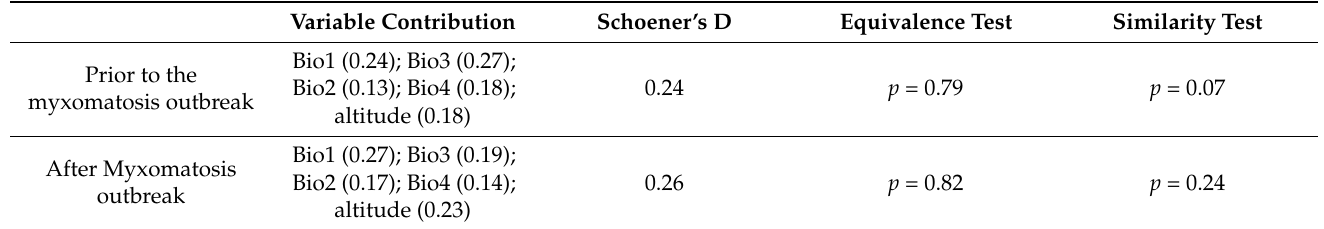
Table 5. Schoener’s D and p -values of equivalence and similarity test under conservatism hypothesis. Contribution of variables also provided. Bio1–Bio4: four levels of CORINE Land